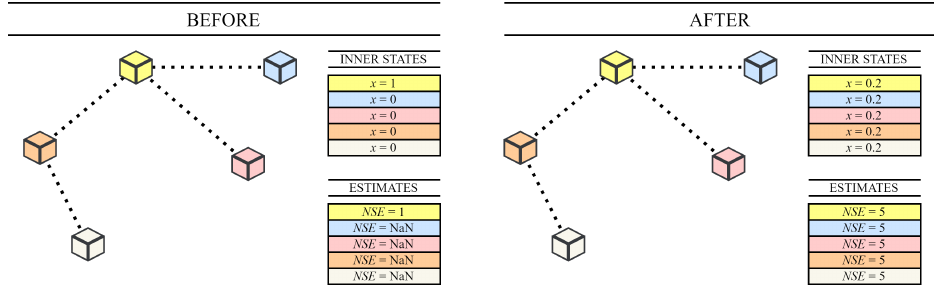
Figure 5. Comparison of inner states/arithmetic mean estimates before and after consensus is achieved in multi-agent